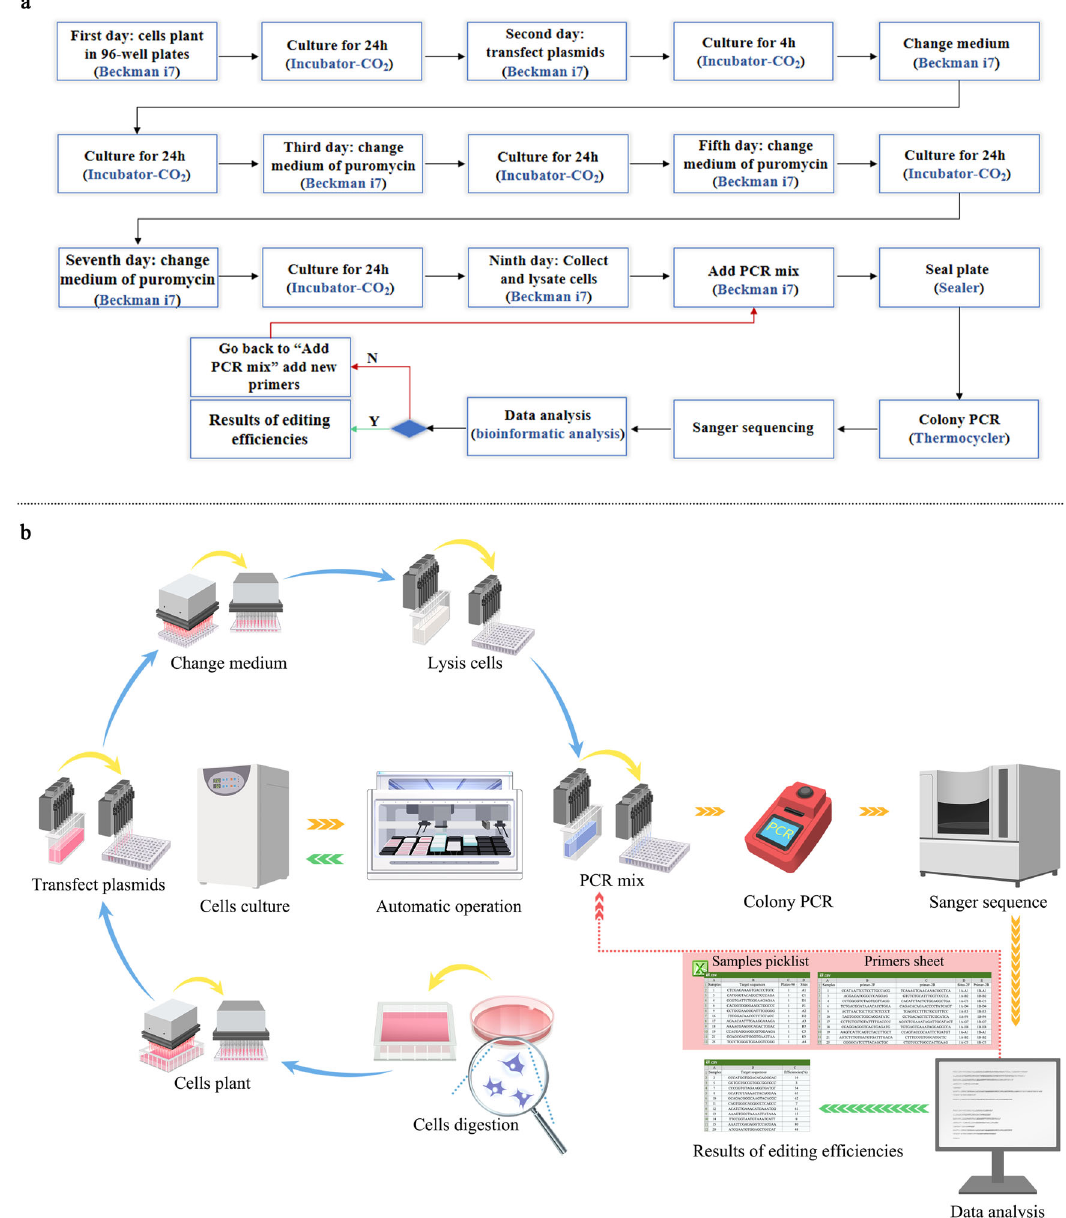
Fig. 3 | Overview of the work fl ow of the automated gene editing process. a A fl owchart showing different instruments to orchestrate the gene editing process. The whole process starts from cultivating cells in 96-well plates, and ends at vali- dation of editing ef fi ciencies. The red arrow means the wrong PCR samples ’ information on sanger sequence, and new primers need to be used for PCR. The green arrow means correct PCR samples ’ information on sanger sequence, and editing ef fi ciencies can be made downstream for AI learning. The steps of